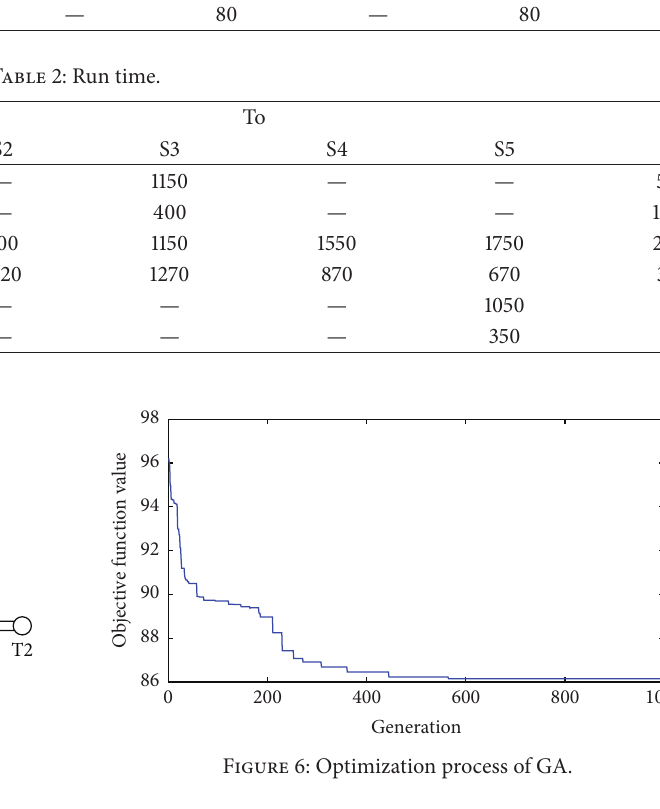
Figure 5: A sample transit network.